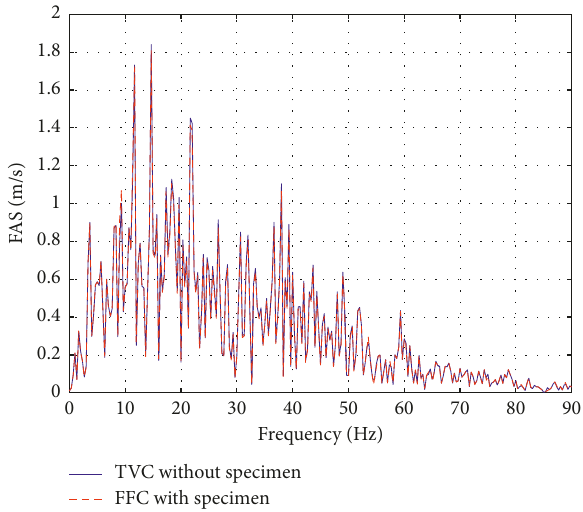
Figure 16: Acceleration Fourier amplitude spectrum of the dual shaking tables without/with specimen under TVC/FFC.